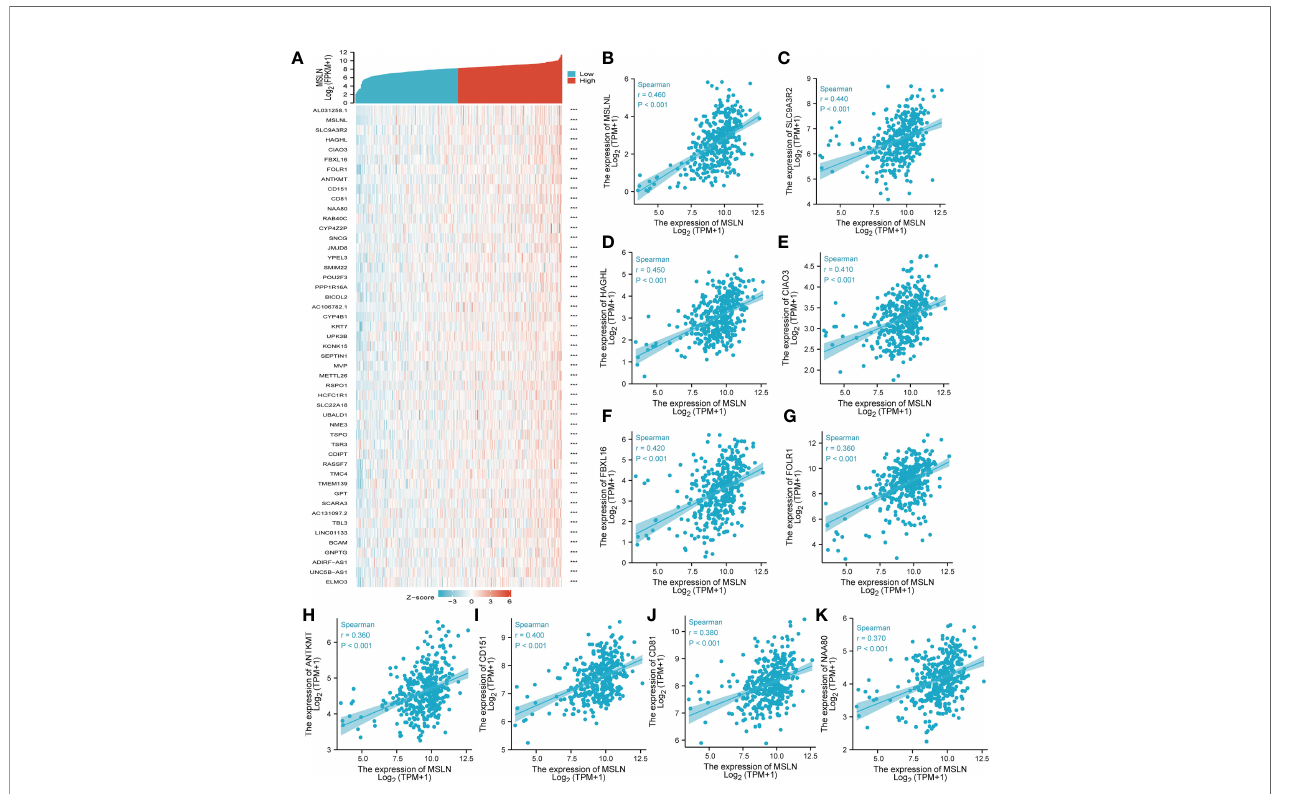
FIGURE 4 | Top 50 genes positively correlated with MSLN expression in ovarian cancer. (A) The gene co-expression heatmap of the top 50 genes positively correlated with MSLN in ovarian cancer. (B – K) Correlation analysis of the top 10 genes and MALN in the heatmap. ***, p